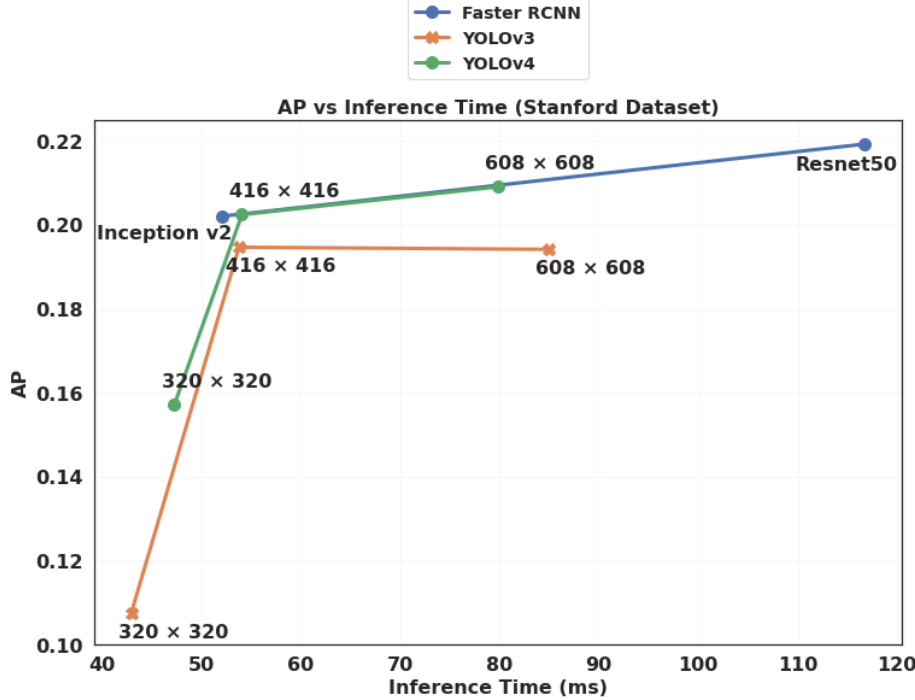
Figure 20. Comparison of the trade-off between AP (Average Precision) and inference time for YOLOv4 and YOLOv3 (with 3 different input sizes each) and for Faster R-CNN (with two different feature extractors), on the Stanford